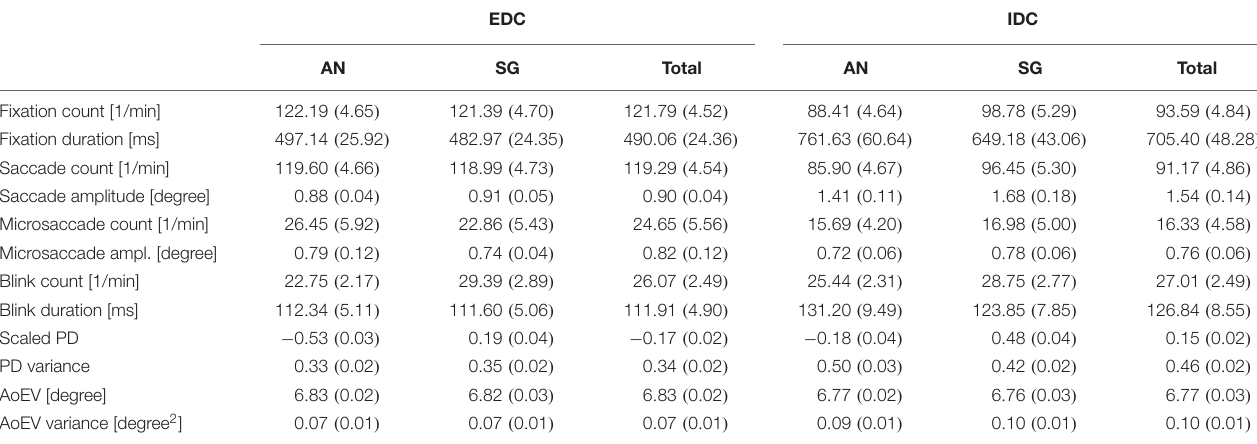
TABLE 1 | Mean (and SE) for each oculometric parameter during externally directed cognition (EDC) versus internally directed cognition (IDC) for both